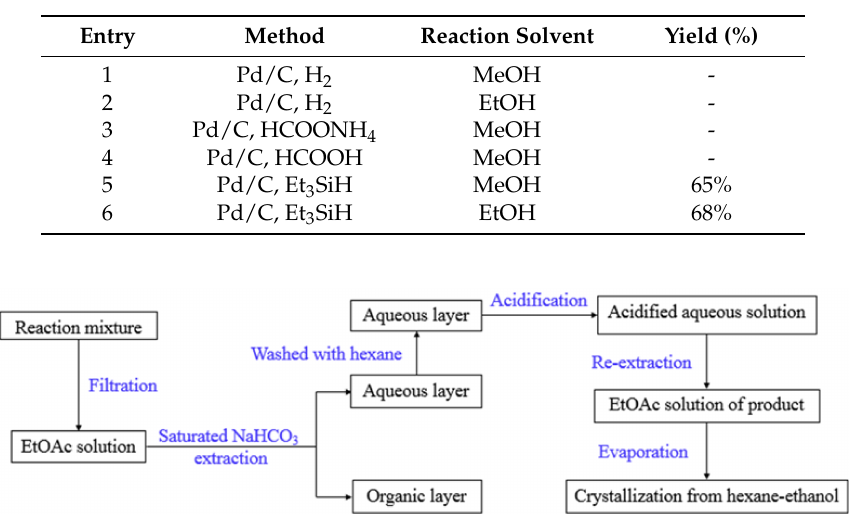
Table 2. Reaction conditions optimization of benzyl deprotection in the synthesis of 5 .